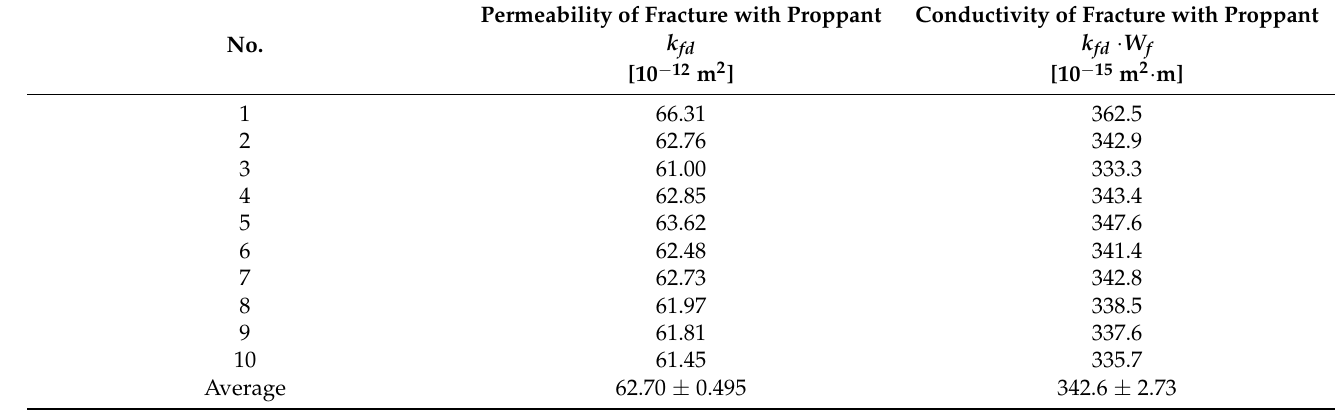
Table 11. The measurement results for the determination of the original conductivity and permeability of the fracture filled with light ceramic proppant 20/40 damaged by the fluid FF2B at 60 ◦ C; compressing stress 41.4